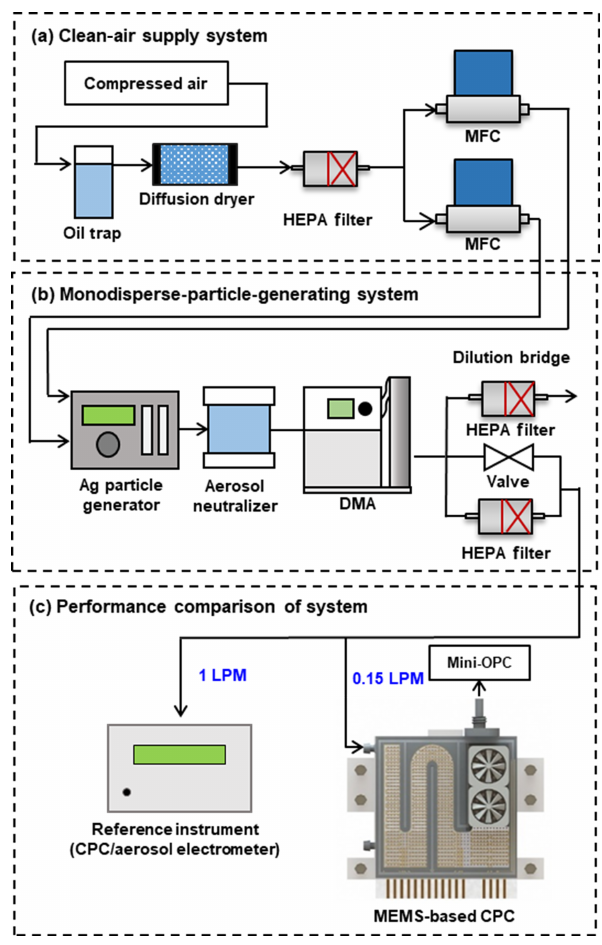
Figure 4. Schematic of the experimental setup for evaluating the performance of the MEMS-based